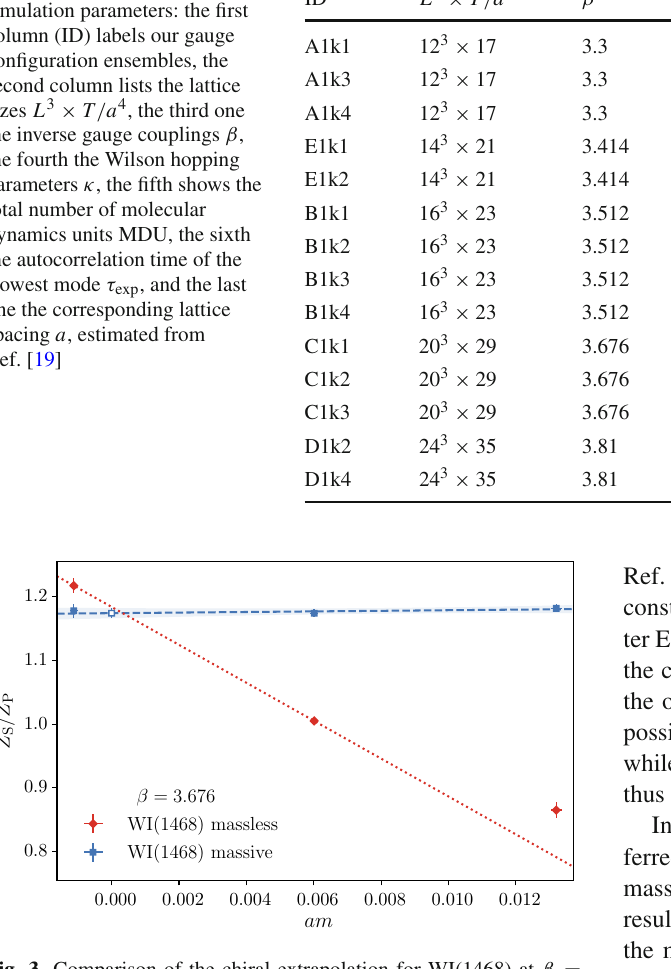
Table 4 Summary of simulation parameters: the first column (ID) labels our gauge configuration ensembles, the second column lists the lattice